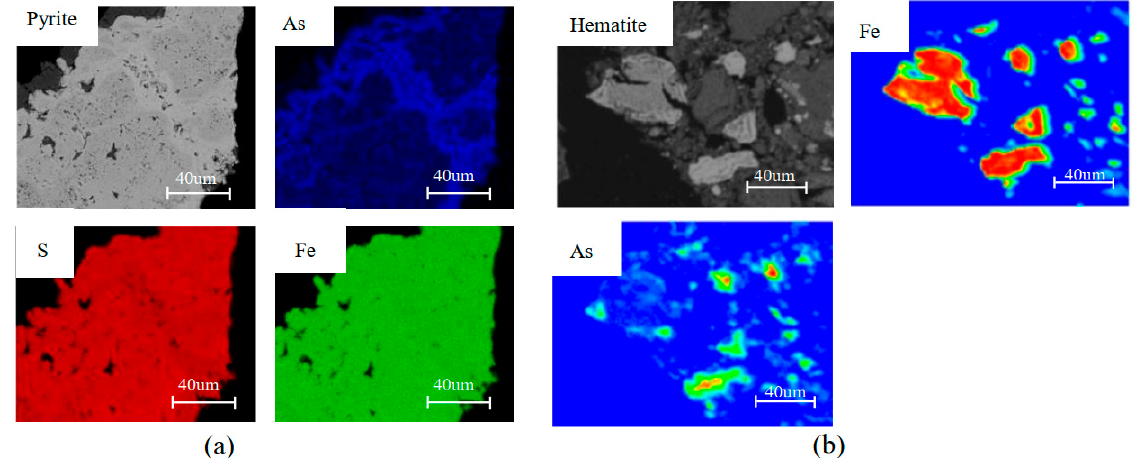
Figure 8. The electron probe microanalysis of pyrite ( a ) and hematite in calcine ( b ).